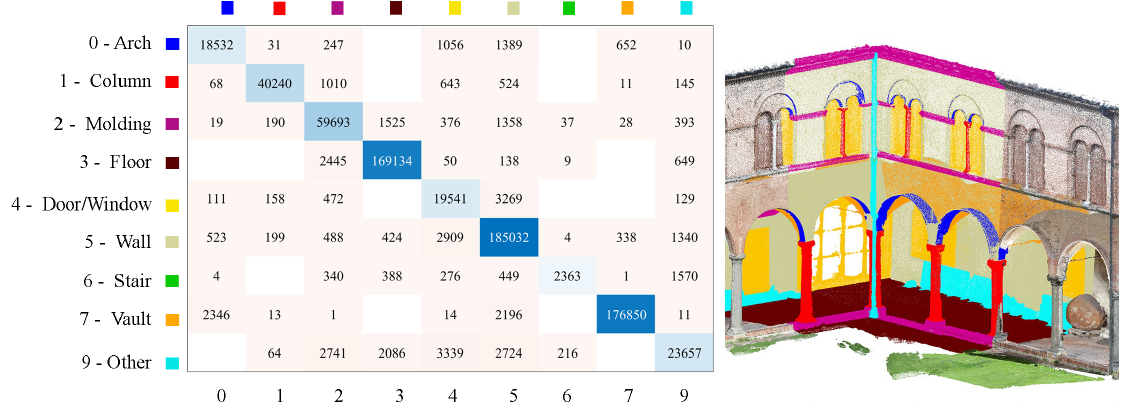
Figure 4. Confusion matrix for the National Museum of San Matteo dataset with related training set.